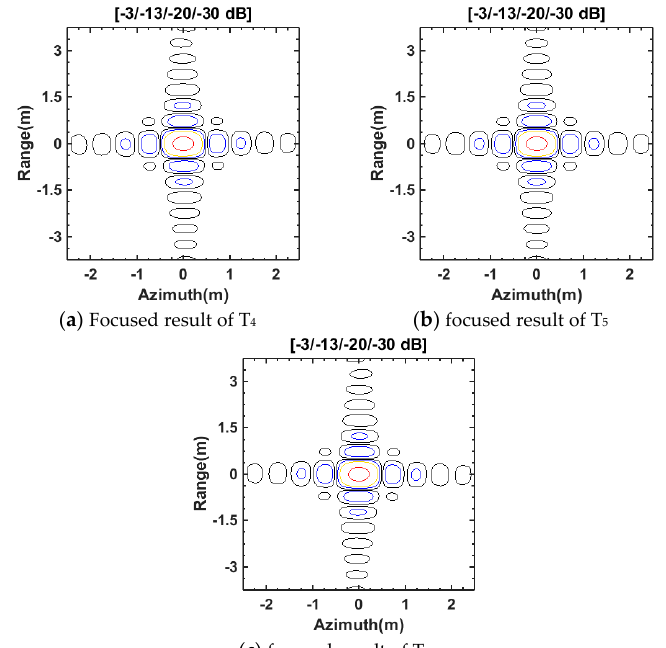
Figure 11. Focused point target results of T 1 , T 2 , and T 3 : ( a ) focused result of T 1 ; ( b ) focused result of T 2 ; and ( c ) focused result of T 3 .